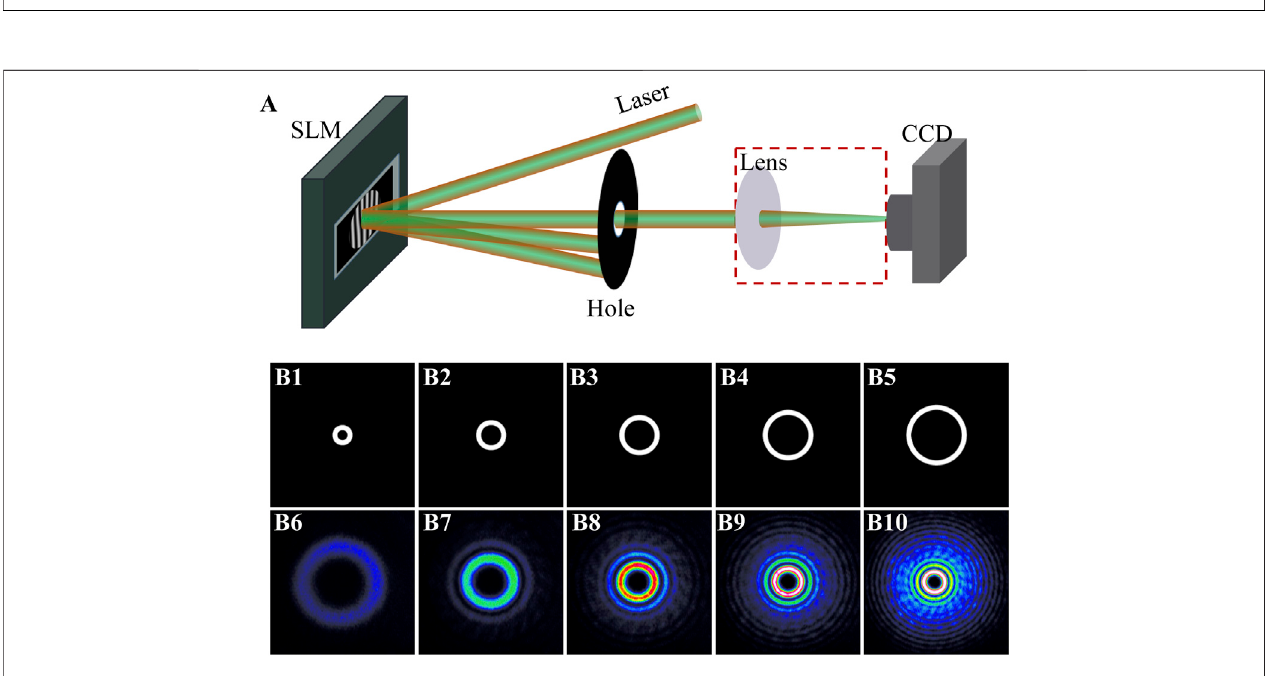
FIGURE 3 | Experimental setup and results for propagation and evolution of a vortex beam. (A) Schematic representation of the experimental setup. (B1 – B5) Transmissionringswithdifferentouterradiiof0.86,1.29,1.72,2.15,and2.58 mminthecaseofthesameringwidthof0.43 mm,respectively. (B6 – B10) Corresponding measured intensity distribution in the case of l = 5 and the propagation distance z = 1 m, respectively. All images have the same dimension of 6.2 mm × 6.2 mm.